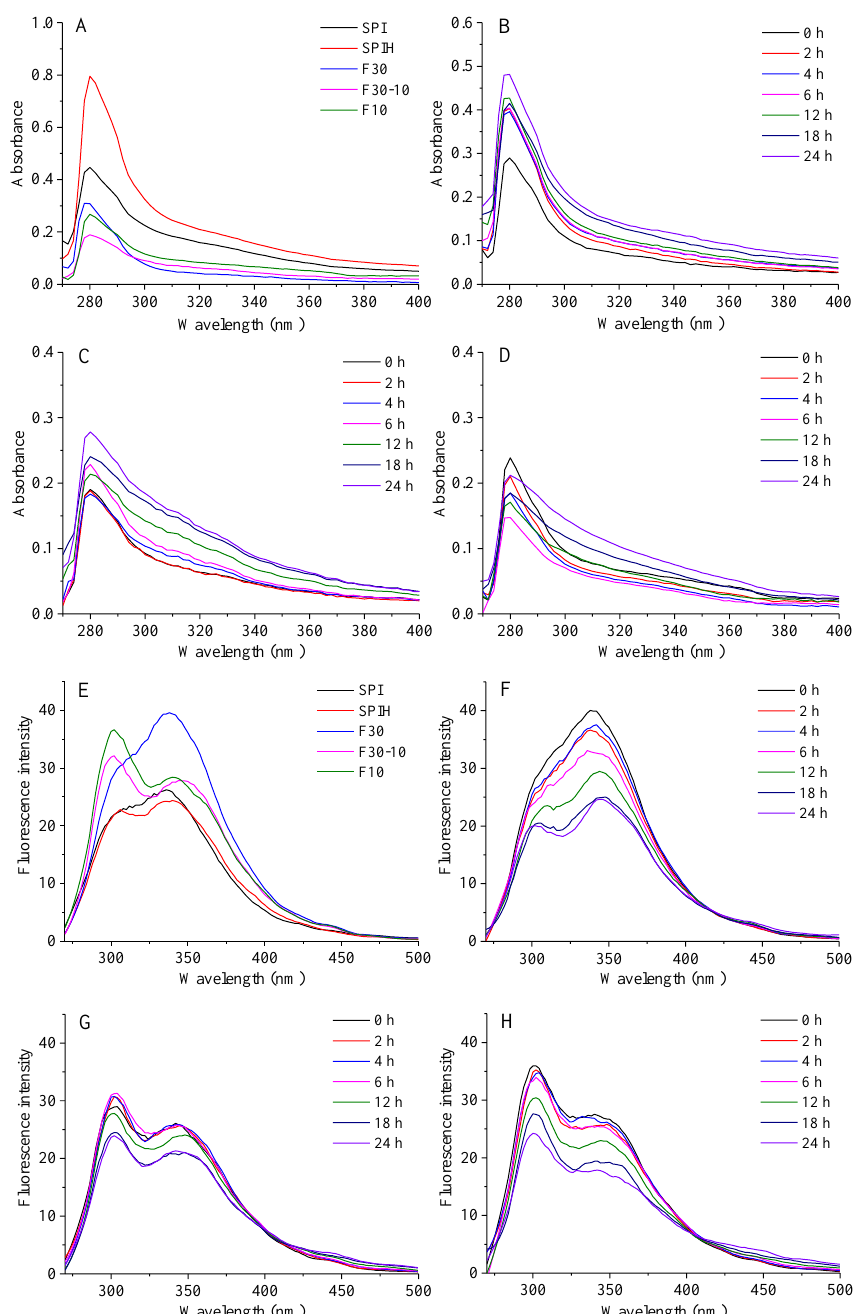
Figure 3. Ultraviolet spectra ( A – D ) and fluorescence spectra ( E – H ) of SPI, SPIH, F30, F30-10, and F10 ( A , E ), and F30-dextran ( B , F ), F30-10-dextran ( C , G ), and F10-dextran ( D , H ) conjugates incubated for 0, 2, 4, 6, 12, 18, and 24